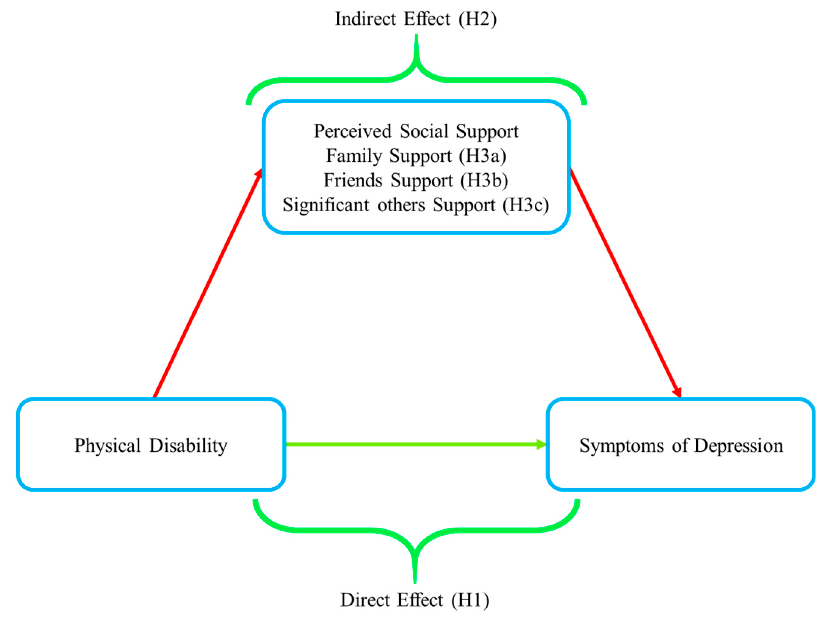
Figure 1. Hypothetical model.